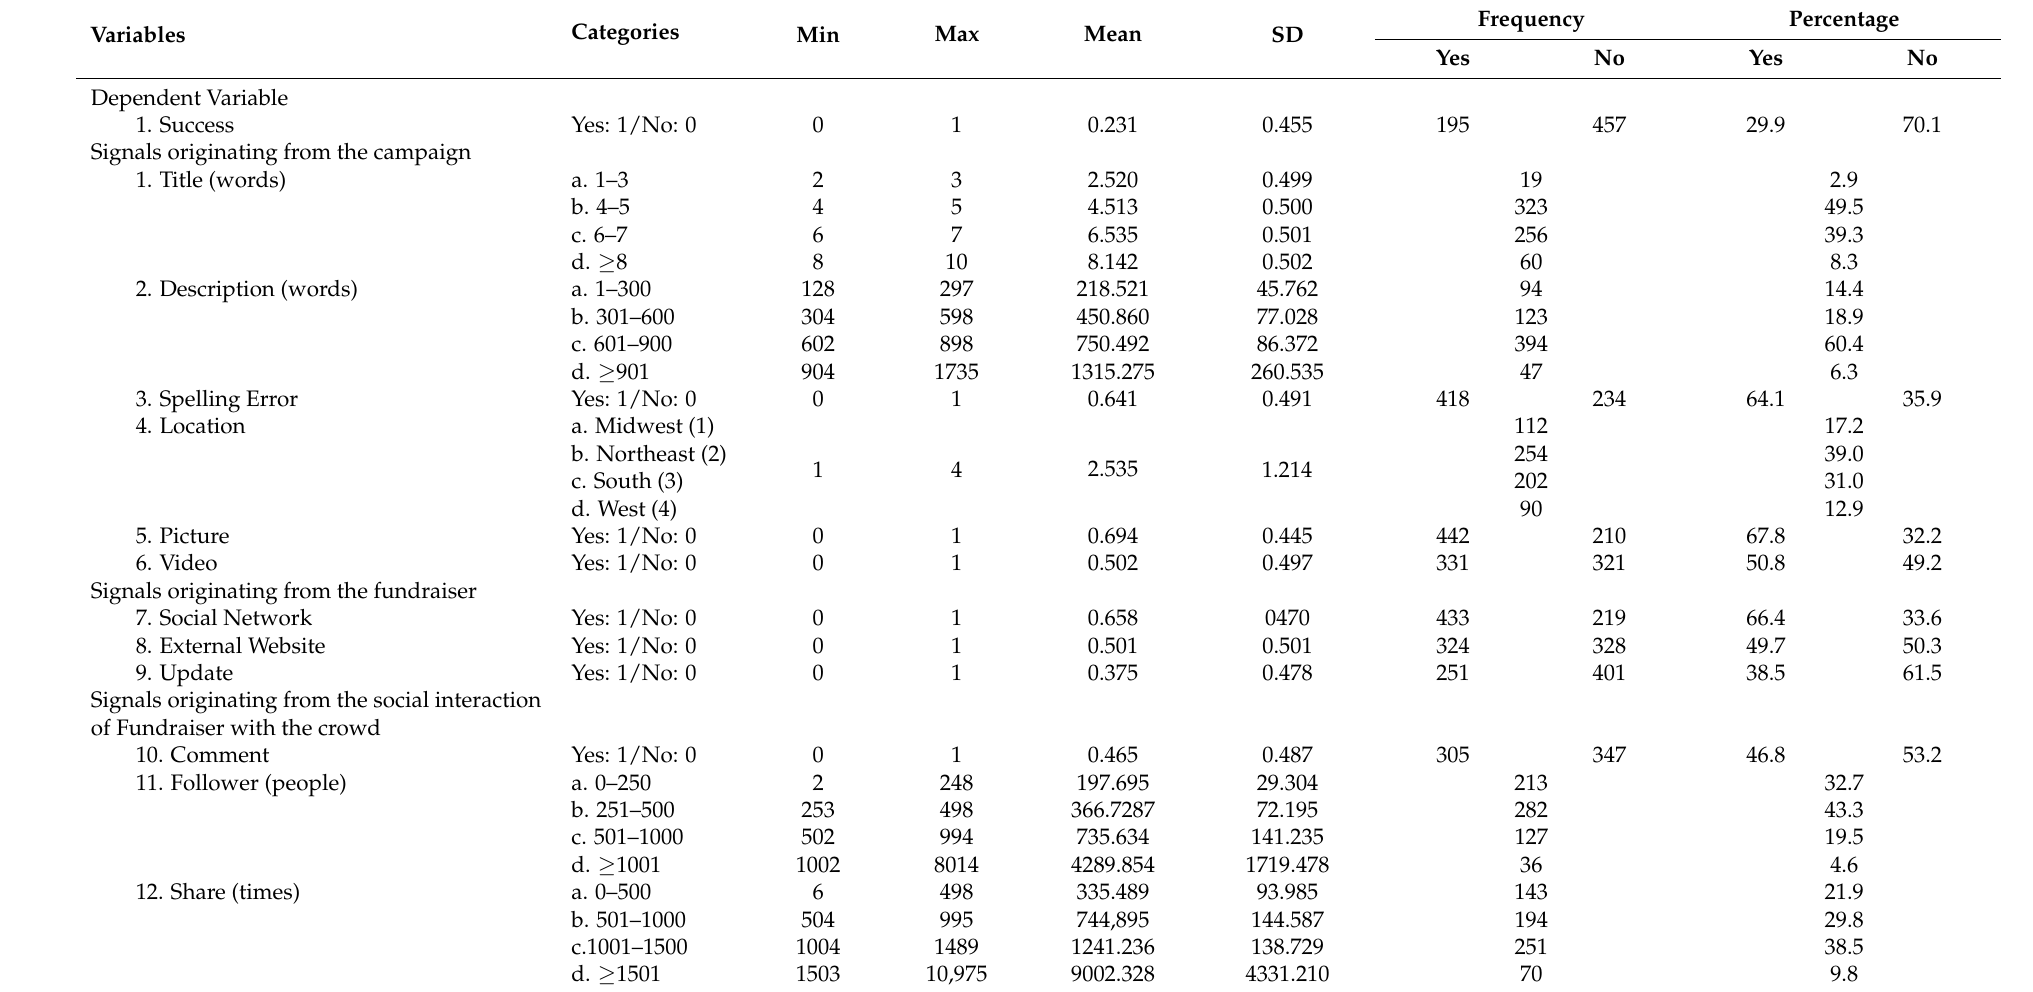
Table 3. Summary statistics of crowdfunding campaigns ( n =